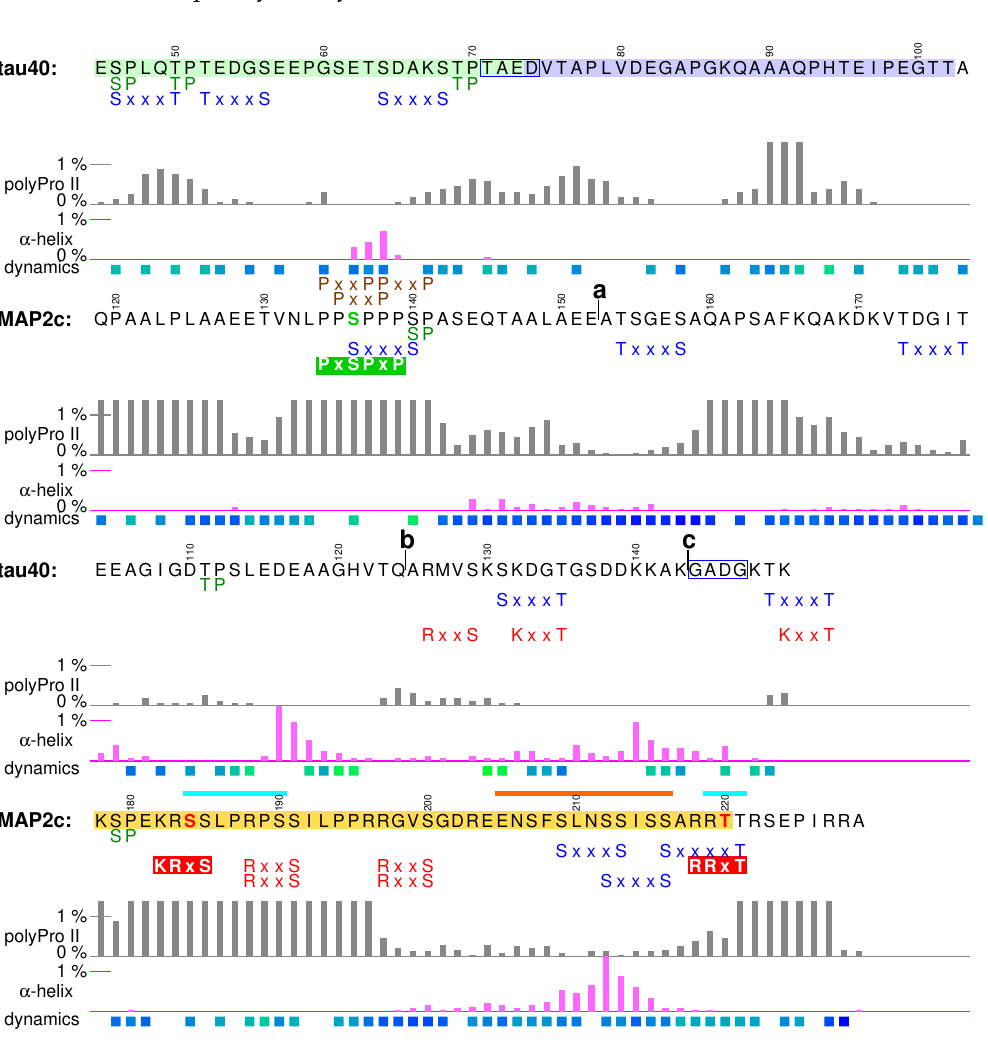
Figure 4. Sequences of variable central regions preceding the proline-rich domains of human tau40 and rat MAP2c. Tau inserts I1 and I2 are shown in pale green and pale blue boxes, respectively. The motif in the yellow box is described in the text. PKA recognition motifs and residues rapidly phosphorylated by PKA in vitro are shown in red. Interactions of MAP2c with plectin and 14-3-3 proteins are shown as orange and cyan bars above the sequence. Letters a , b , and c show position of long exons in the high-molecular weight tau and MAP2 isoforms. Other symbols are used as described for Figure